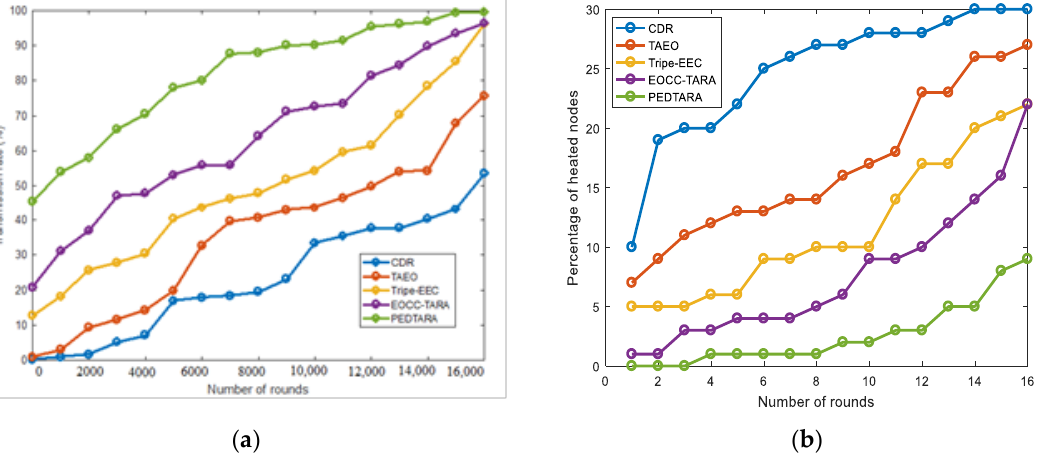
Figure 10. Comparison of transmission rate and percentage of heated nodes: ( a ) transmission rate; ( b ) percentage of heated nodes. Table 11. Transmission rate (%).